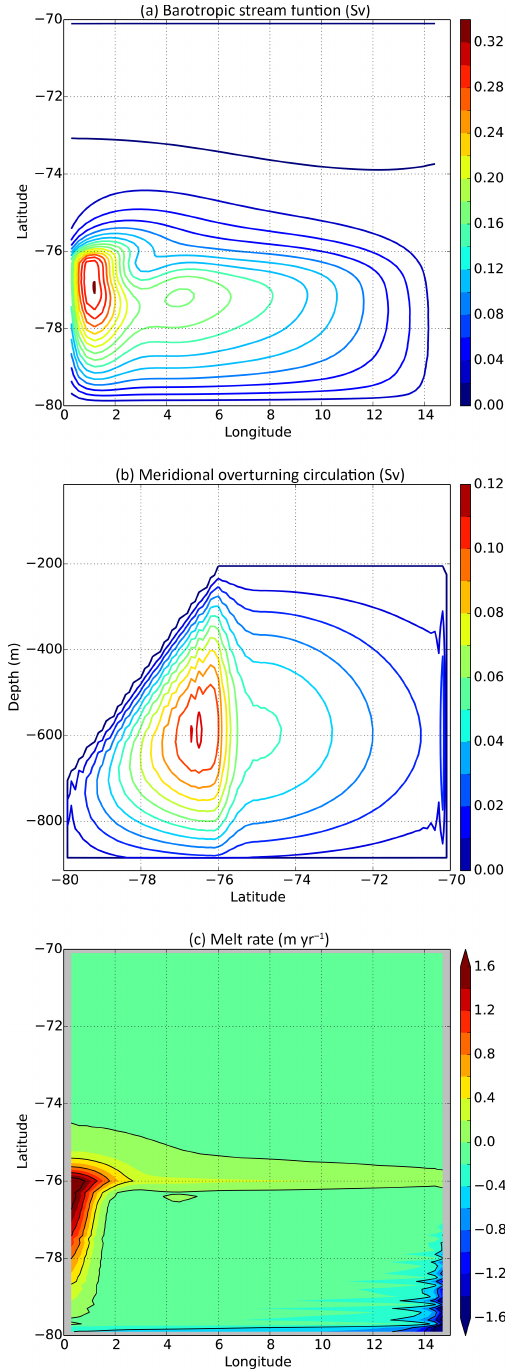
Figure 2. Near-steady-state (after 10000days) solution of the I_30M ISOMIP experiment. (a) Horizontal stream function (Psi) in Sv with a contour interval of 0.02Sv. (b) Meridional overturn- ing circulation (moc) in Sv with a contour interval of 0.01. (c) Melt rate in myr − 1 (negative for melting and positive for freezing) with a contour interval of 0.4myr − 1